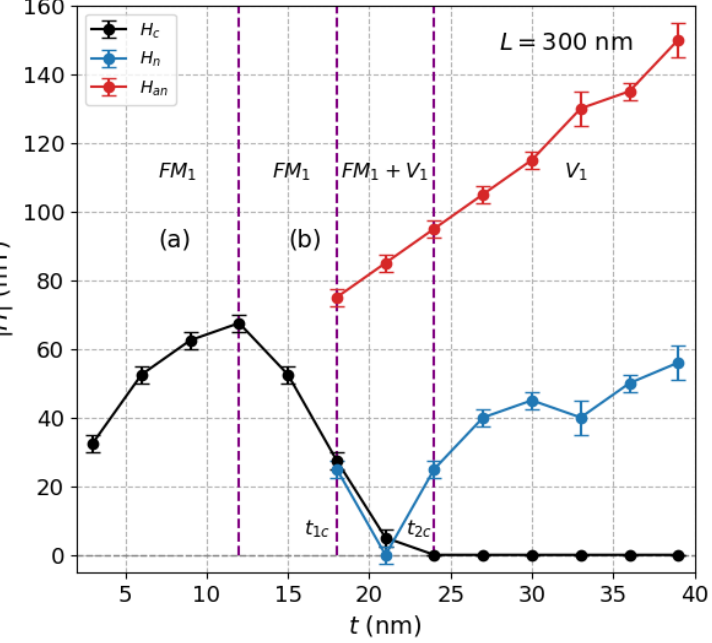
Figure 2. Thickness dependence of the absolute value of coercivity ( H c ), nucleation field ( H n ) and annihilation field ( H an ) for prisms with L = 300 nm. This plot shows the regions corresponding to the phases FM 1 , (FM 1 + V 1 ), the pure vortex states V 1 , and the respective transition thickness values t 1 c and t 2 c